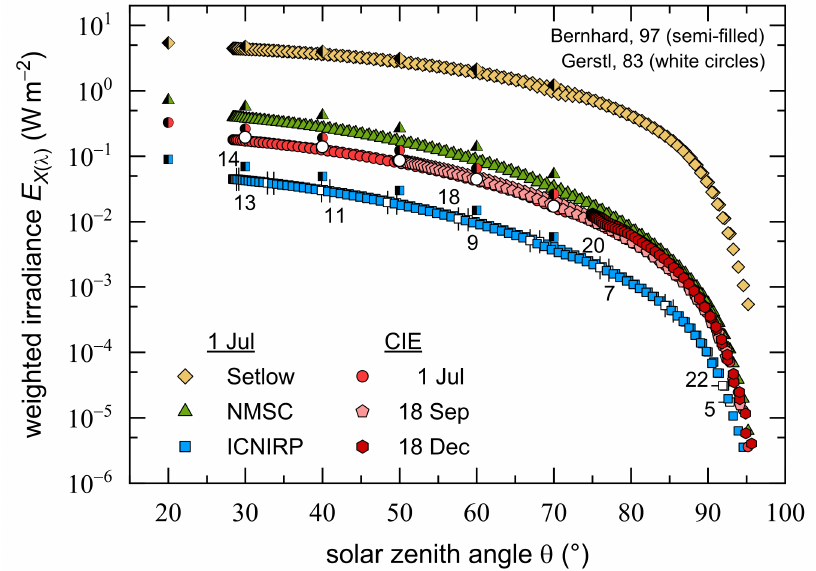
Figure 3. Semi-logarithmic presentation of SZA dependent UV irradiances measured on the 1 July 2018 (cloudless day) at Dortmund, Germany (latitude 51.5 ◦ N), and weighted either with CIE’s reference erythema action spectrum [24], the NMSC weighting function [25], ICNIRP’s relative spectral sensitivity for UVR hazards [31], or the melanoma action spectrum proposed by Setlow [27]. Erythemally weighted irradiances for cloudless days close to 2018 (cid:48) s autumn equinox (23 September) and winter solstice (21 December) are compared to those from 1 July 2018. White squares highlighted by either vertical or horizontal dashes and labelled with numbers mark full daytime hours (local time). In addition, weighted irradiances based on data from Bernhard et al. [29] (semi-filled symbols, latitude 19.3 ◦ S, 11 January 1996) and Gerstl et al. [30] (white circles, latitude 50 ◦ N) are also